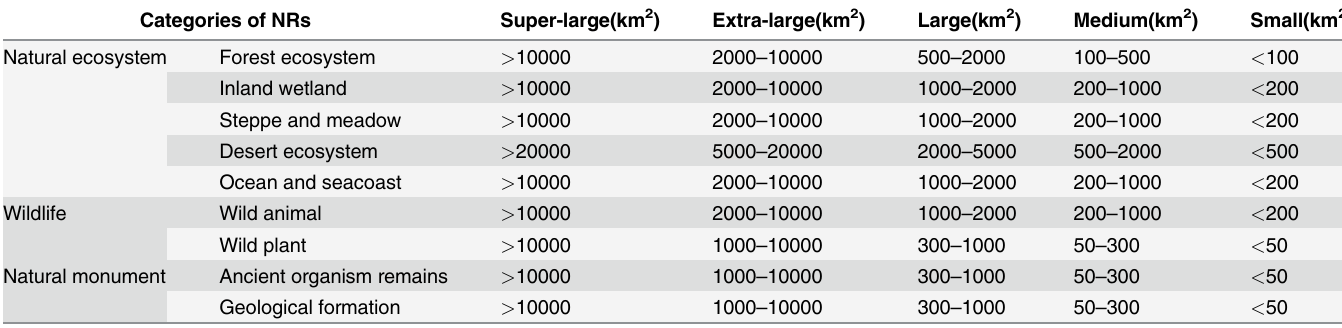
Table 1. Grade standard of NR sizes in mainland